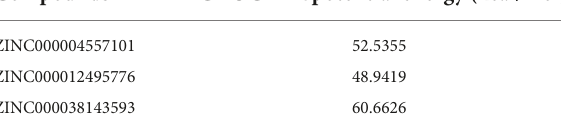
TABLE 5 CDOCKER potential energy of compounds with granzyme